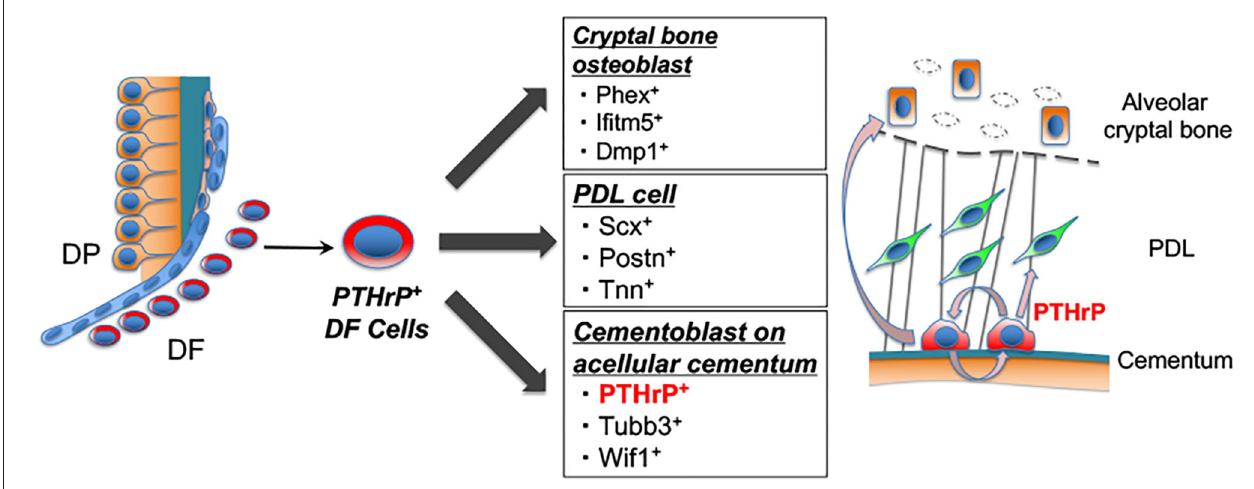
FIGURE 5 | PTHrP + DF cells contribute to attachment apparatus formation and PTHrP is a specific marker for cementoblast. Shown is the concluding diagram of this study. PTHrP + DF cells give rise to osteoblasts, PDL cells, cementoblasts. After attachment apparatus formation, PTHrP is specifically expressed in cementoblasts. Our computational analysis suggests that PTHrP secreted from cementoblasts is important for cementogenesis via PTH/PTHrP receptor signaling.